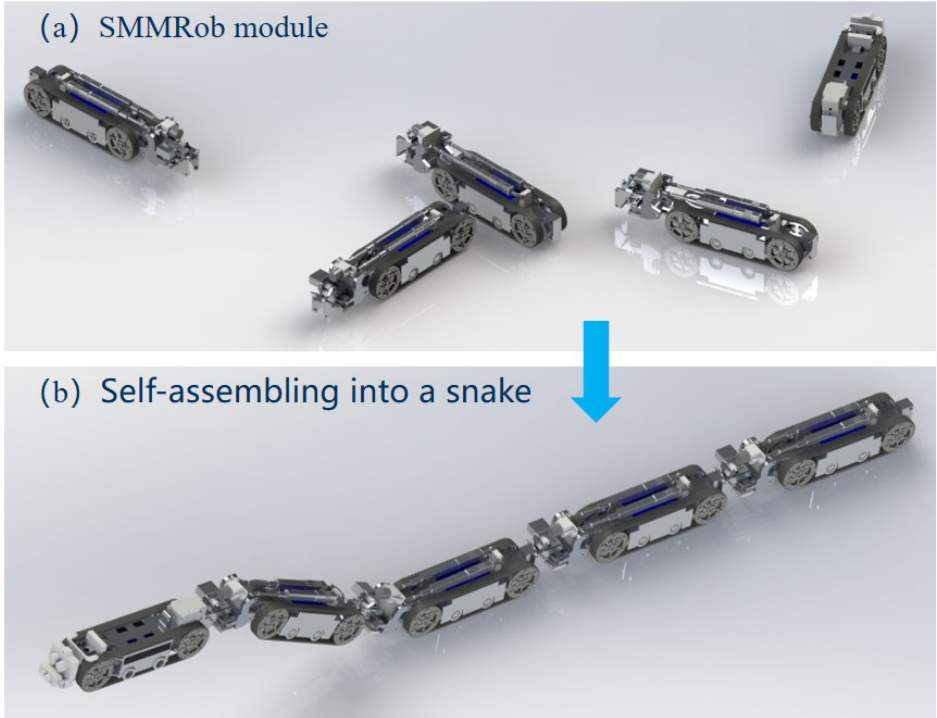
Figure 2. A self-assembling mobile modular robot system consisting of a group of self-contained robot modules and modules with a different function forming the head. ( a ) Each homogeneous SMMRob module with a different payload can move, sense, manipulate, and dock individually. ( b ) The robot modules can connect together to form a snake-like high-level system that can move on tracks with joints.